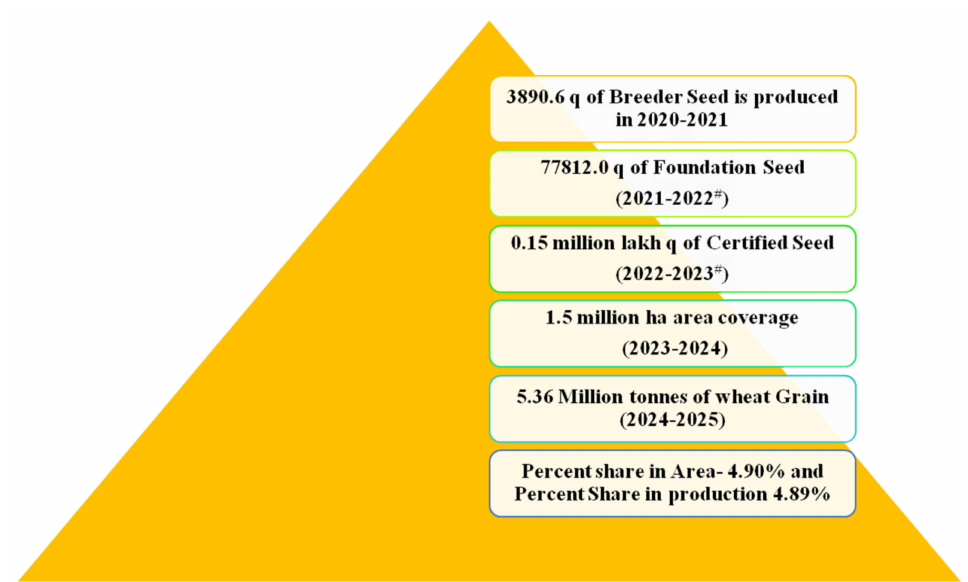
Figure 3. Projected impact of biofortified wheat @ 100% conversion of breeder seed into certified seed (# percent share in area and production is calculated as per the fourth advance estimate during 2020–2021 of wheat area (31.61 M ha); production (109.52 million tons), productivity of 3464 kg/ha. andseed rate@100